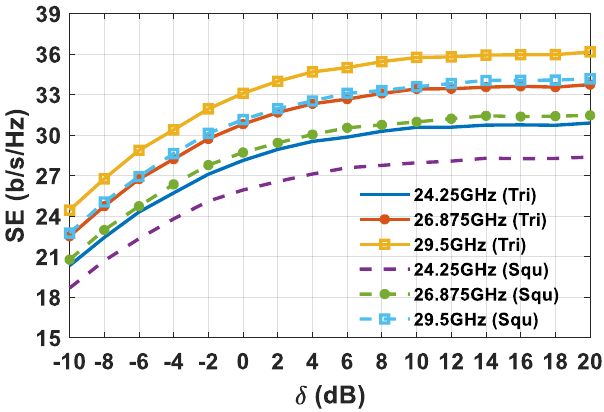
Figure 16. SE comparison for a planar array composed of 8 × 8 elements, in cases of square and triangular lattices, as a function of the δ ratio in dB in the event of 8 concurrent